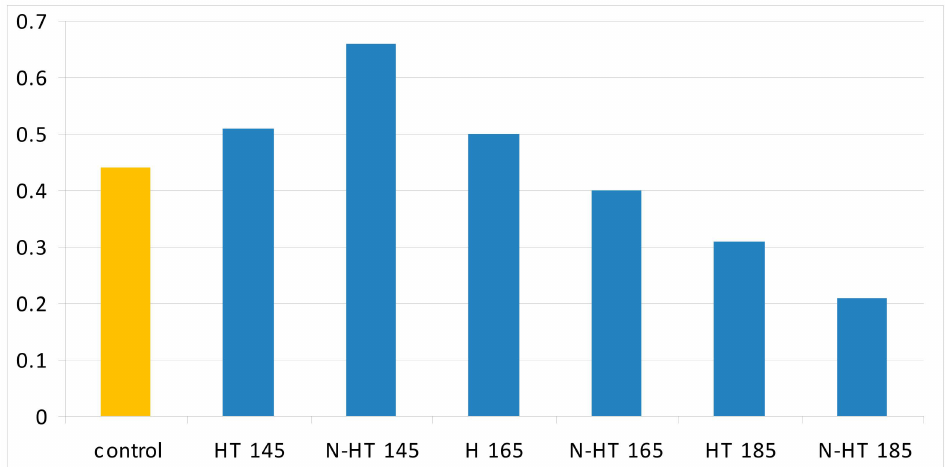
Figure 5. Crystallinity in the seven treatments studied in the present project (HT = heat treatment at a determined temperature; N = nanosilver